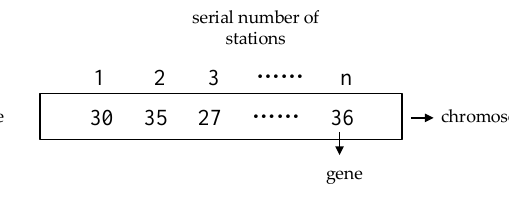
Figure 11. Schematic diagram of dwell time encoding.